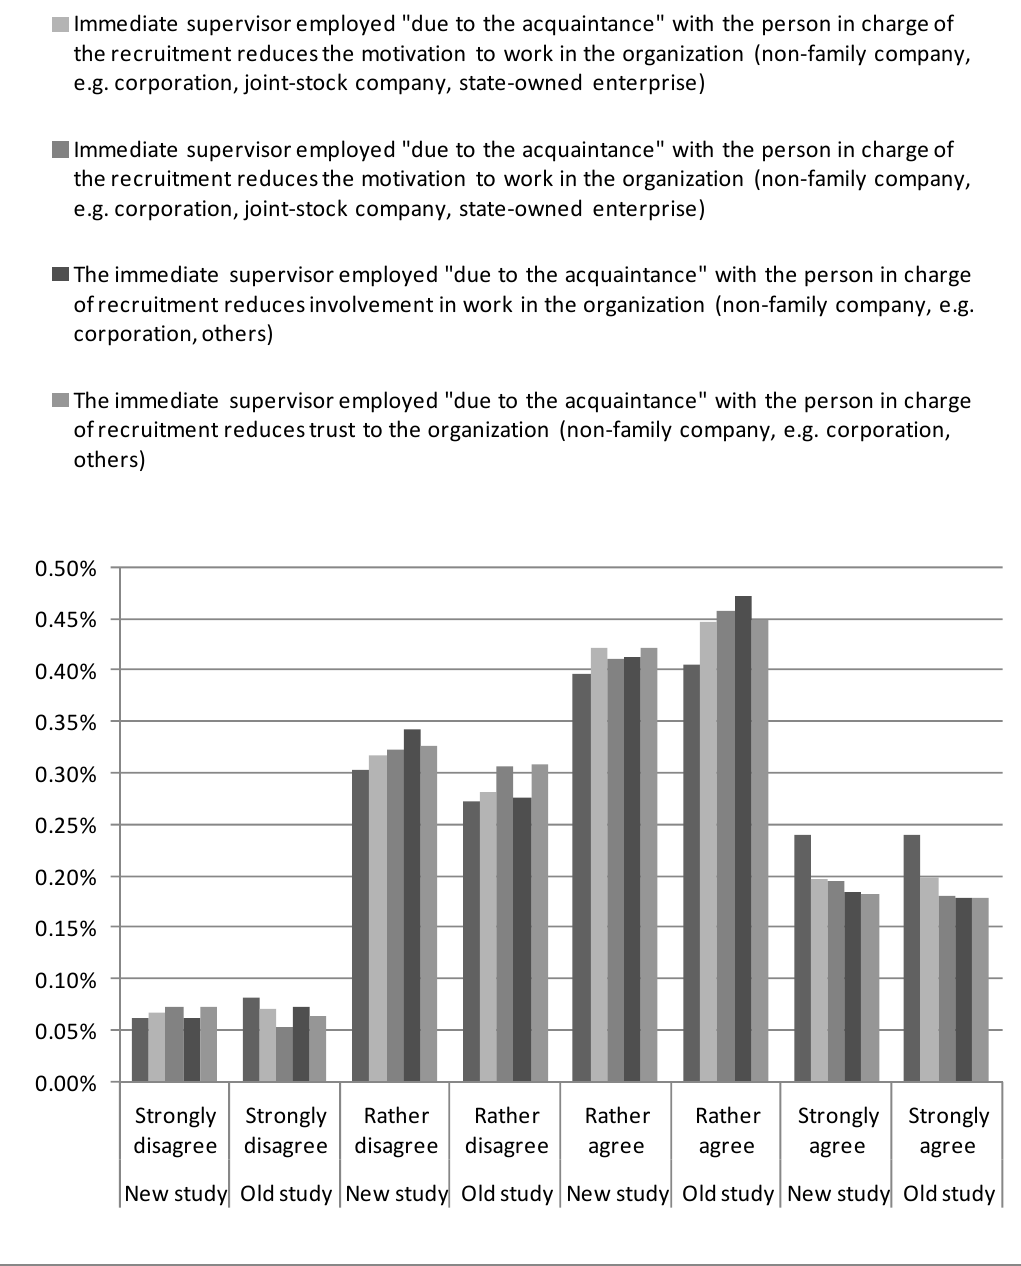
Figure 5. Influence of cronyism on employees in a non-family business. Source: authors’ own elaboration.